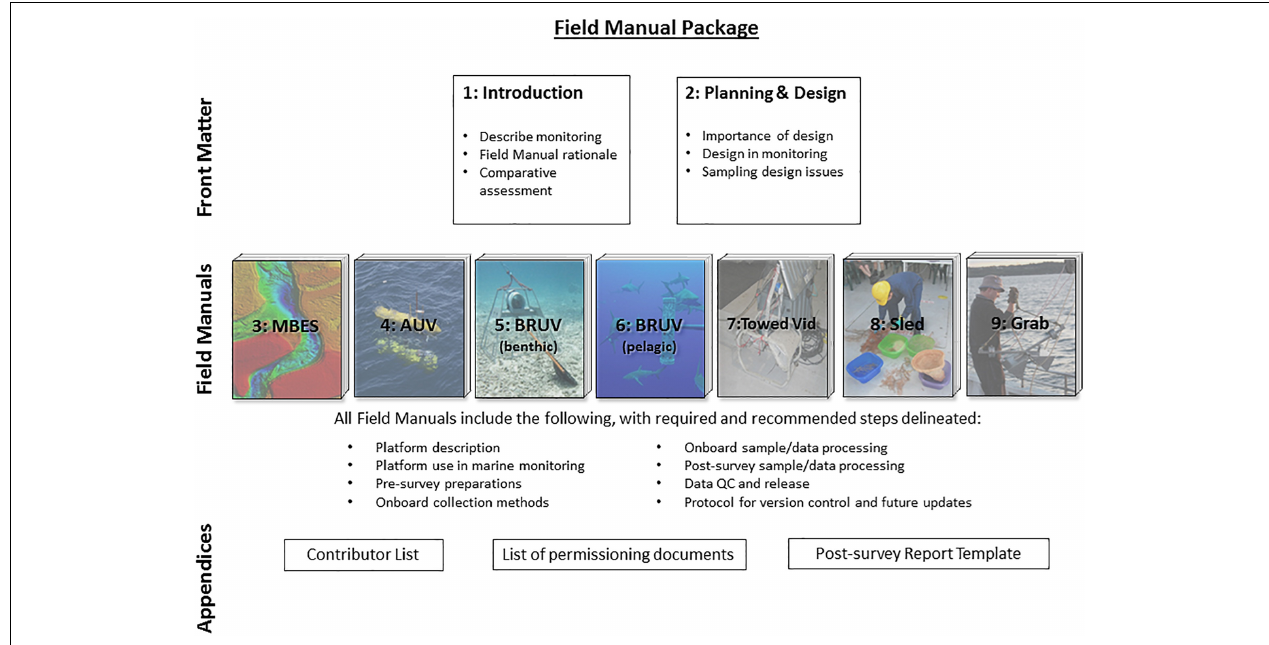
FIGURE 1 | The format of Field Manuals for Marine Sampling to Monitor Australia’s Waters , from Przeslawski and Foster (2018). Numbers indicate chapters, with chapters 2–9 representing standalone manuals that present